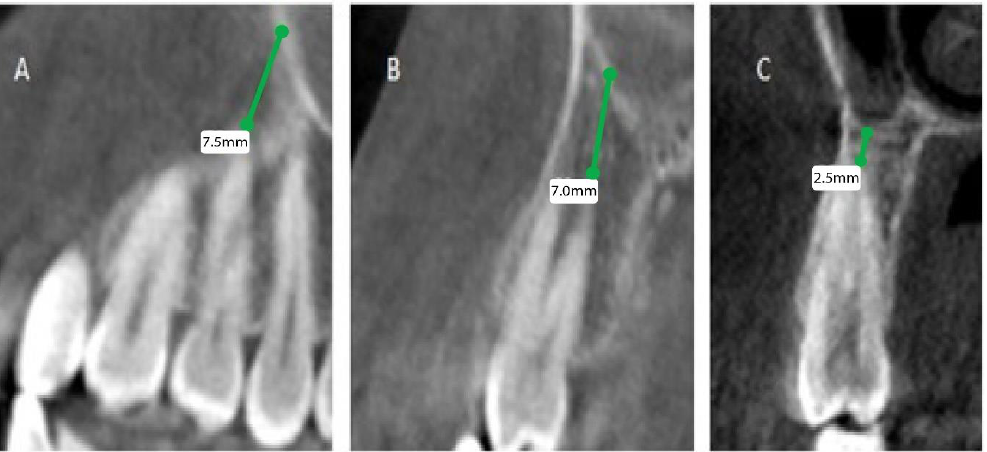
Figure 1. CBCT sagittal view showing the distance between the maxillary sinus and the root of permanent maxillary (right). ( A ) First premolar buccal root, ( B ) first premolar palatal root, ( C ) second premolar